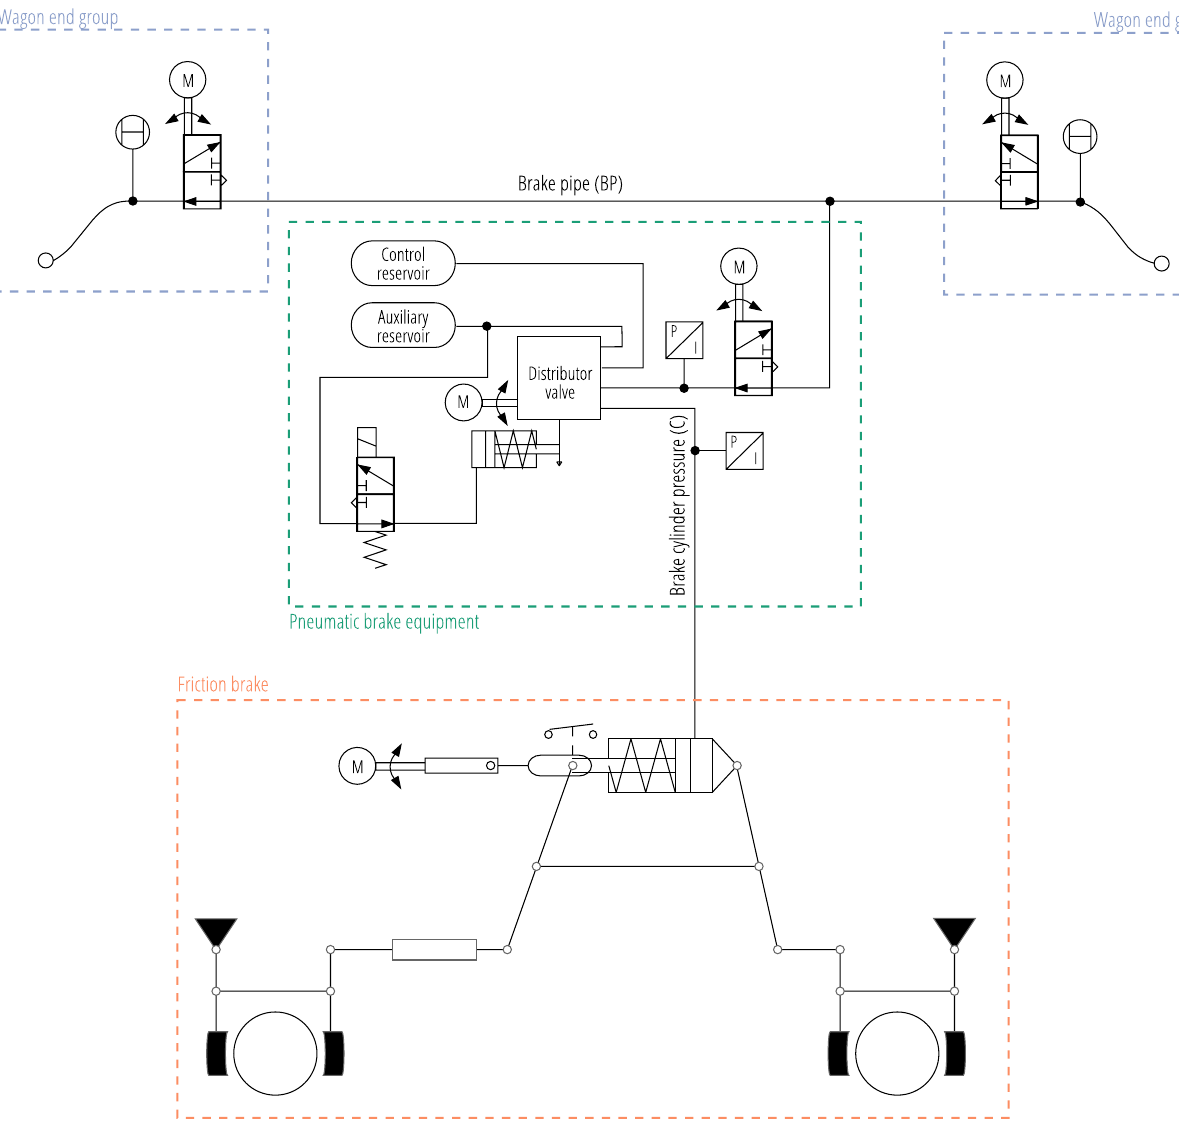
Fig. 7 Automated pneumatic brake schematic for Wagon